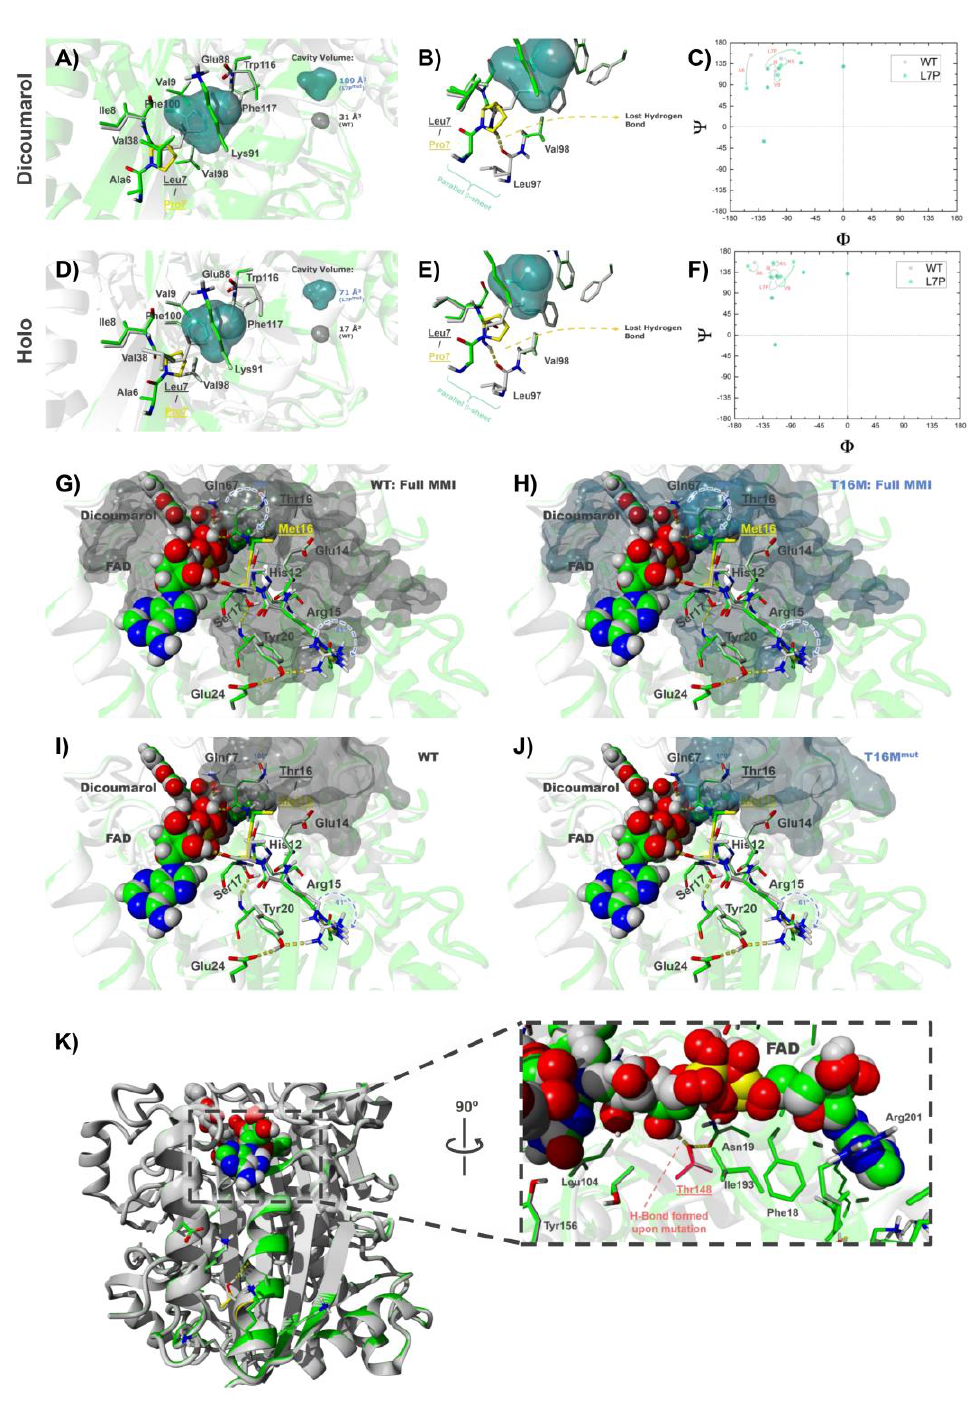
Figure 8. Detailed structural analysis of the mutations L7P ( A – F ), T16M ( G – J ) and A29T ( K ). ( A ) Overall view of the L7P site in the NQO1 dic state (mutated residue in yellow). The mutation generates a cavity in the hydrophobic core of the protein (semi-transparent blue for L7P and gray for WT protein). ( B ) Close-up view on the hydrogen bond disrupted by L7P in the NQO1 dic state. ( C ) Ramachandran plot of the first ten amino acids in the NQO1 dic state. Arrows indicate the displacement in dihedral angles caused by L7P mutation that a ff ects the β -sheet pattern near the mutated site. ( D ) Close-up of the mutated site (in yellow) in the NQO1 holo state. The mutation L7P generates a cavity in the hydrophobic core of the protein represented in semi-transparent blue (L7P) and gray (WT). ( E ) Zoom-in on the hydrogen bond formerly established by L7 and disrupted by the L7P mutation in